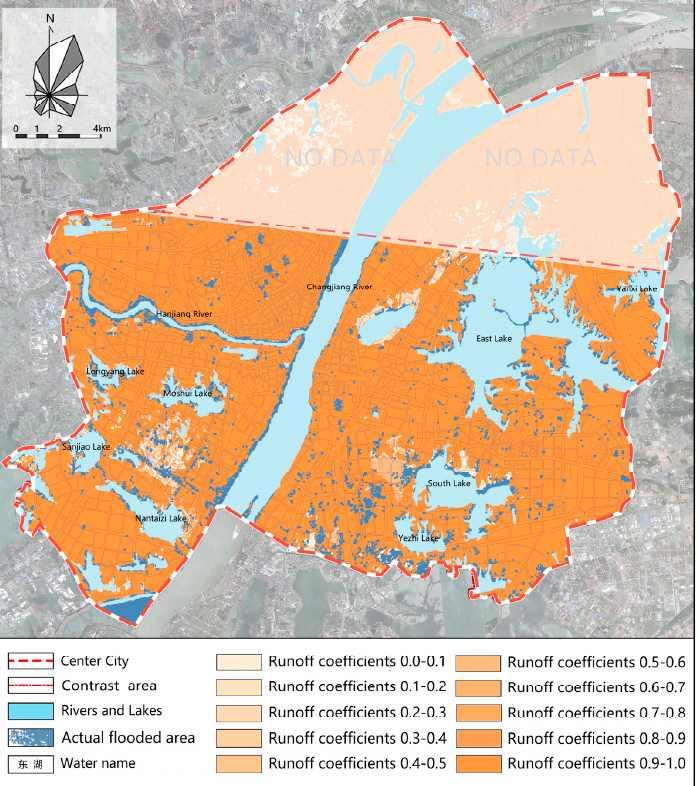
Figure 16. Spatial characteristics of the flood-submerged areas in south downtown Wuhan based on the SCS-CN.